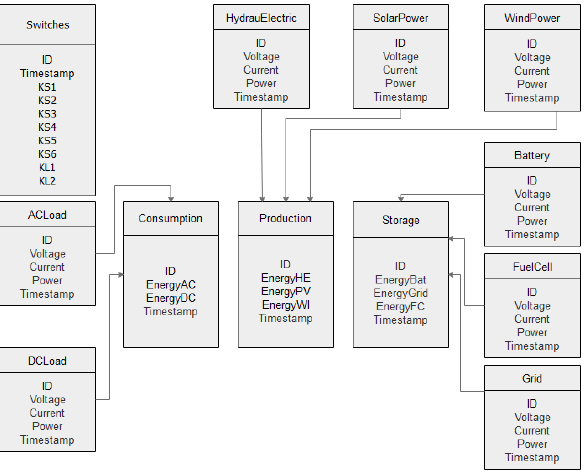
Figure 21. Basic database architecture of the test bench.